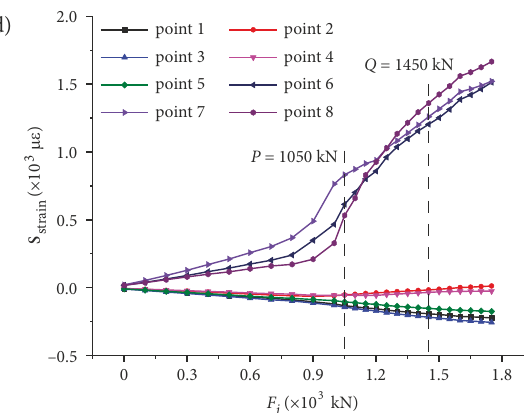
Figure 7. The curves of strain-based and GSED-based stress- ing state modes with respect to load for cross section B: (a) the S strain - F curve for surface concrete; (b) the S GSED - F curve for sur- face concrete; (c) the S strain -F curve for steel bars; (d) the S strain - F curve for internal concrete